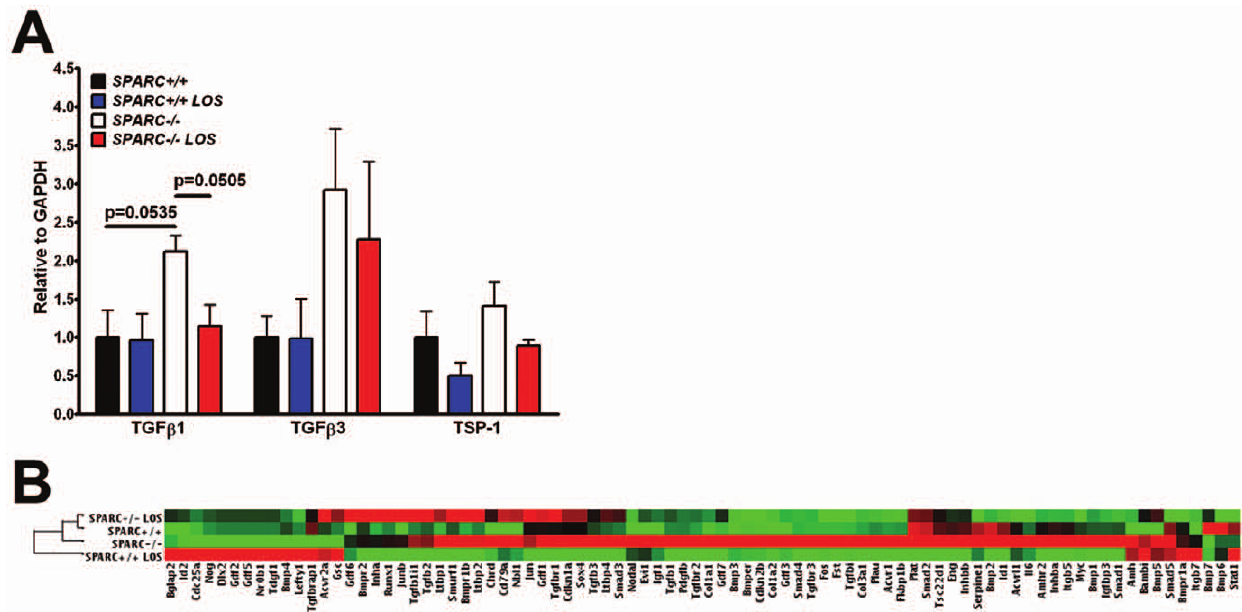
Figure 3. Losartan reduces TGF b -induced gene expression in tumors from SPARC 2 / 2 mice. (A) The mRNA expression of TGF b 1, TGF b 3 and TSP-1 in tumors from SPARC + / + and SPARC 2 / 2 mice treated with losartan was assessed with taqman-based qPCR. n=3/group and p-values were calculated with the Student’s t-test. (B) Clustergram results from the RT 2 Profiler TM PCR Array (PAMM-035; SABiosciences). Green indicates negative fold-regulation, whereas red indicates positive fold-regulation relative to six internal control genes.